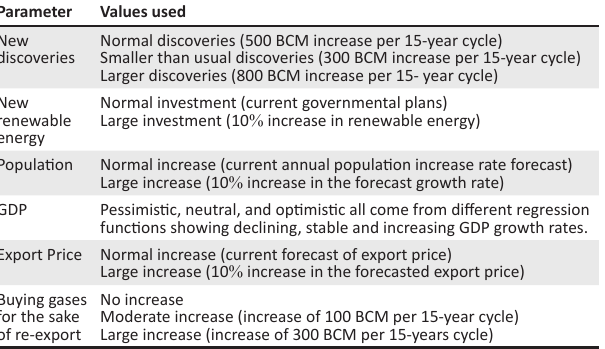
TABLE 1: The different values used in the numerical analysis for all the parameters.